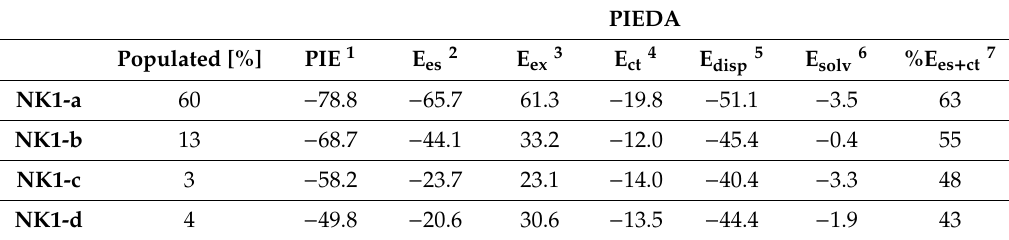
Table 5. Interaction energies (FMO PIEDA, kcal / mol) of the -NH-NH < -Z- d -Trp fragment binding modes at NK1R. PIEDA Populated [%] PIE 1 E es 2 E ex 3 E ct 4 E disp 5 E solv 6